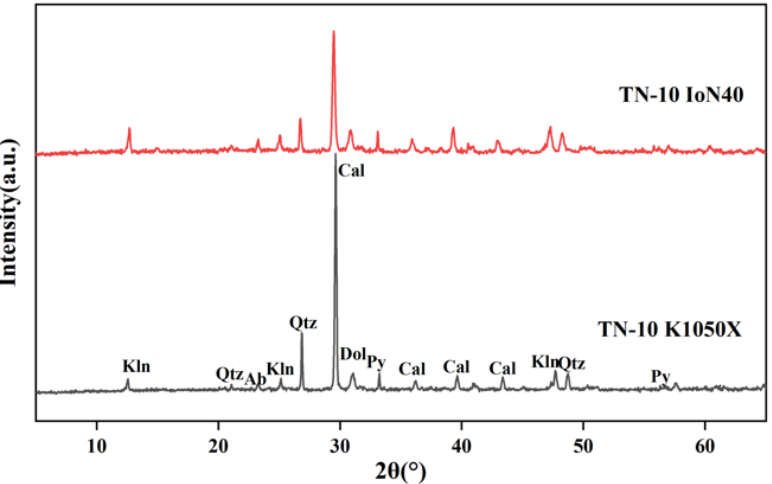
Figure 6. XRD patterns of sample TN-10 ashed by plasma ashers IoN 40 (Program B) and K1050X. Kln: kaolinite. Qtz: quartz. Cal: calcite. Py: pyrite. Ab: albite. Dol: dolomite.